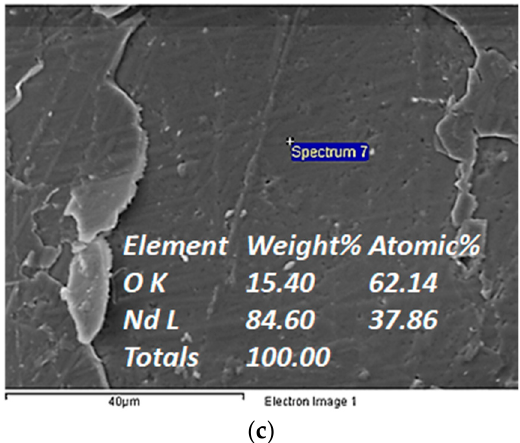
Figure 7. SEM-EDS analysis of the electrodeposits for the three different concentration solutions ( a ) 0.1 M; ( b ) 0.5 M; ( c ) 1 M.